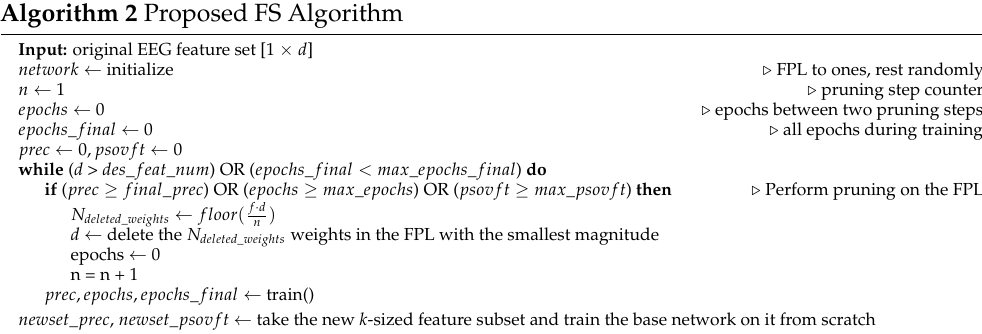
Algorithm 2 Proposed FS